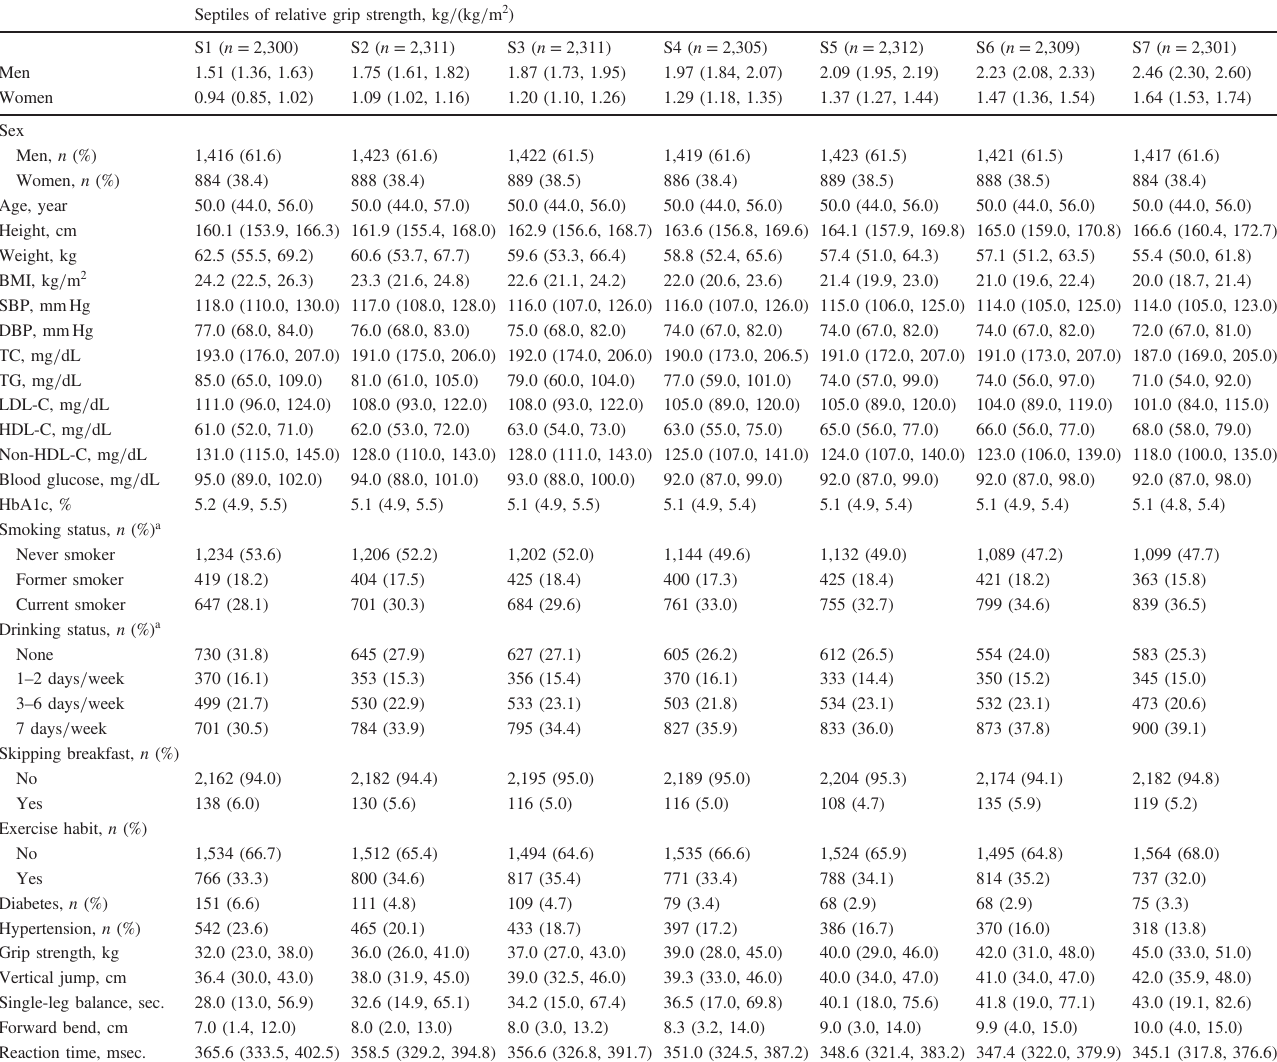
Table 1. Baseline characteristics of participants according to septiles of relative grip strength Septiles of relative grip strength, kg = (kg = m 2 ) S1 ( n =